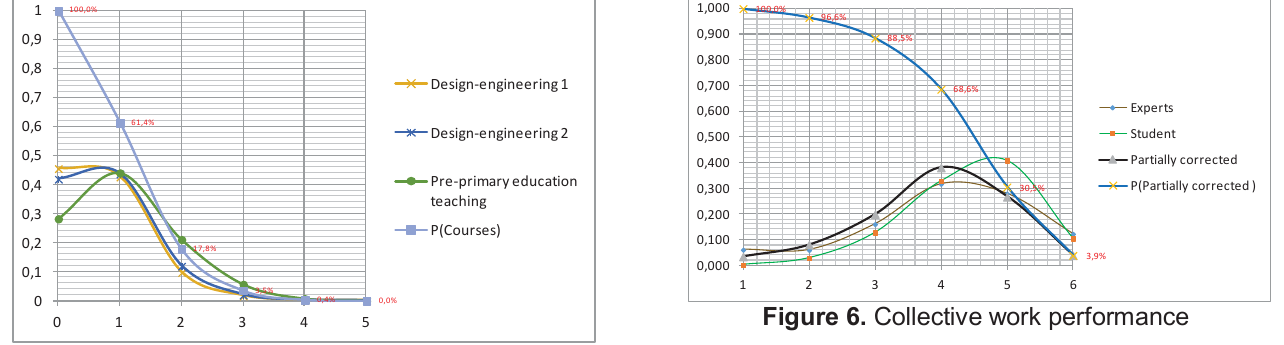
Figure 4. Individual knowledge catching